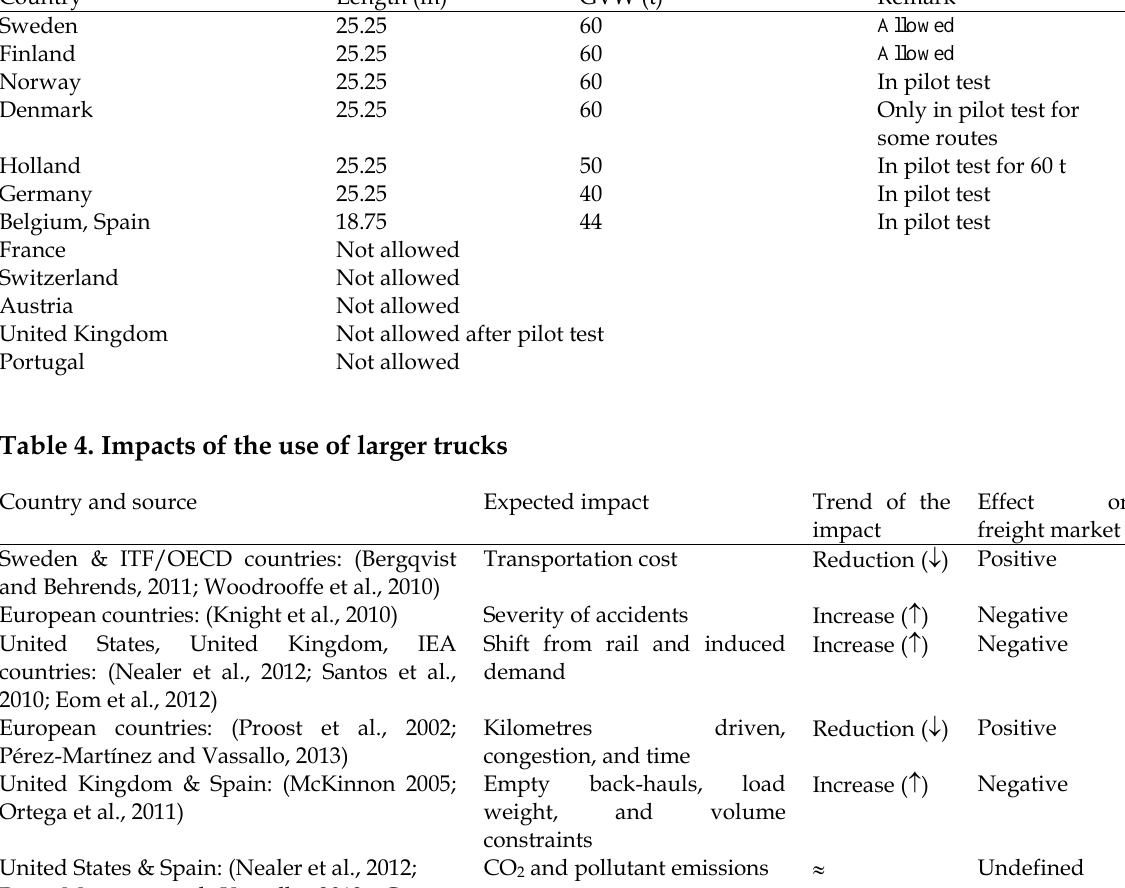
Table 3. European regulations related to longer and heavier vehicles (LHV) Country